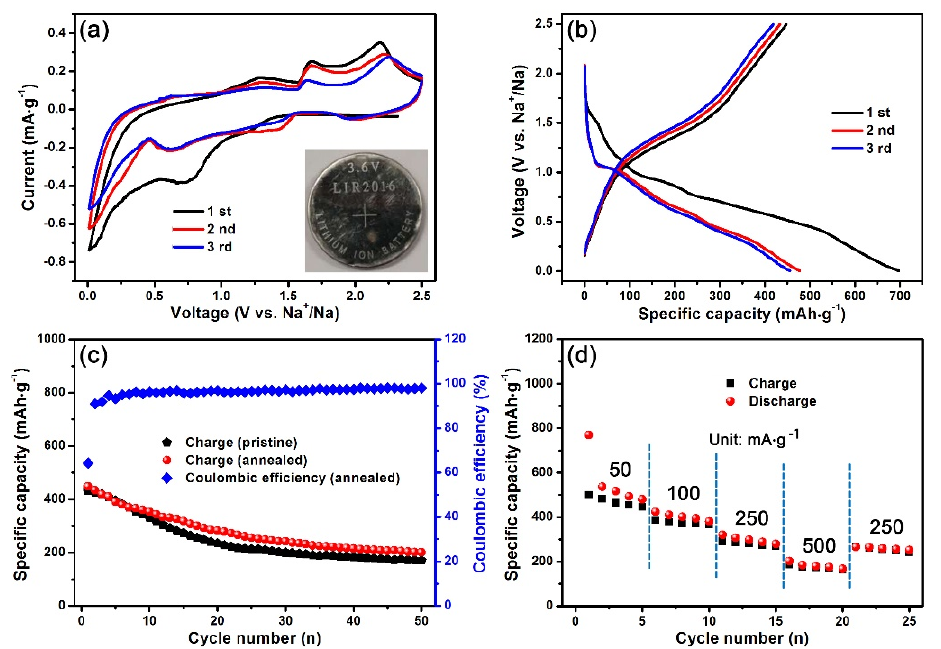
Figure 4. ( a ) CV curves for the first three cycles of annealed CTS at a scan rate of 0.2 mV · s − 1 . Inset in Figure 4a is the photo of 2016 coin type cell; ( b ) Charge/discharge curves of CTS at a current density of 100 mA · g − 1 ; ( c ) Cycling performance of pristine and annealed CTS at a current density of 100 mA · g − 1 ; ( d ) Rate capability of annealed CTS at various current densities of 50–500 mA · g − 1